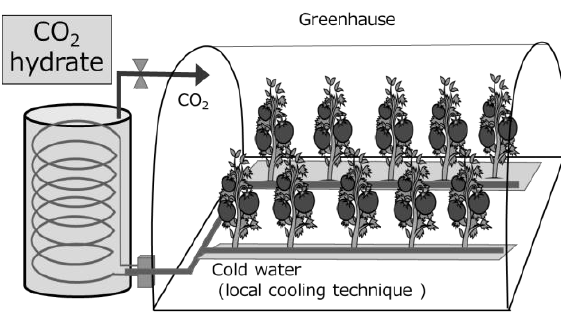
Figure 11. Utilization technology of CO 2 hydrate by combining with a local cooling